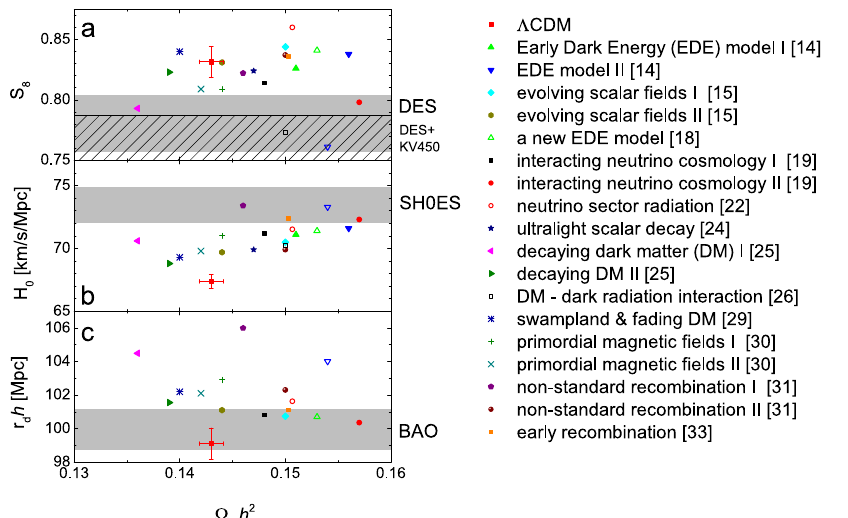
Fig. 3 A compilation of values of Ω m h 2 , r d h , H 0 , and S 8 predicted by some of the models aiming to relieve the Hubble tension by lowering the sound horizon. The best fi t values of S 8 , H 0 , r d h ( a – c respectively), along with Ω m h 2 (the horizontal axis), obtained within the models listed on the right. The horizontal bands show the 68% con fi dence level observational constraint on the corresponding parameter from different (types of) surveys. The sub-labels I and II in the list of models denote either different choices of model parameters within the same model, or constraints derived from different data combinations on the same model. The red square point with error bars represents the Planck best fi t Λ CDM model 1 . With the exception of the red dot, corresponding to the model from 18 with multiple modi fi cations of Λ CDM fi t to Planck temperature anisotropy data only, there is a consistent trend: models with low Ω m h 2 either fail to achieve a suf fi ciently high H 0 or are in tension with baryonic acoustic oscillations (BAO), and models with high values of Ω m h 2 run into tension with the Dark Energy Survey (DES) or the Kilo-Degree Survey